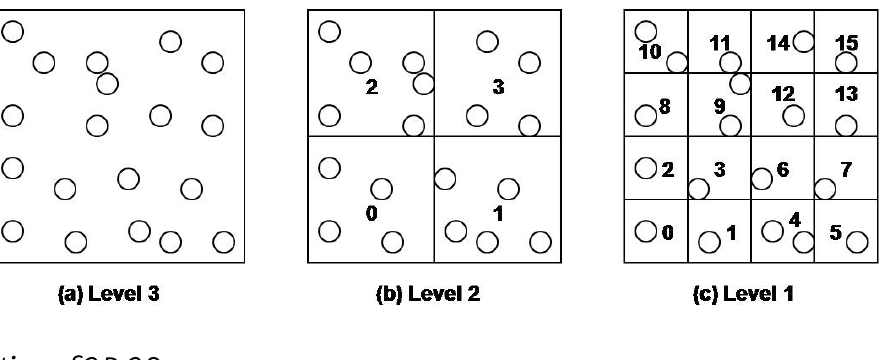
Figure 3. Grid based index when the given level is